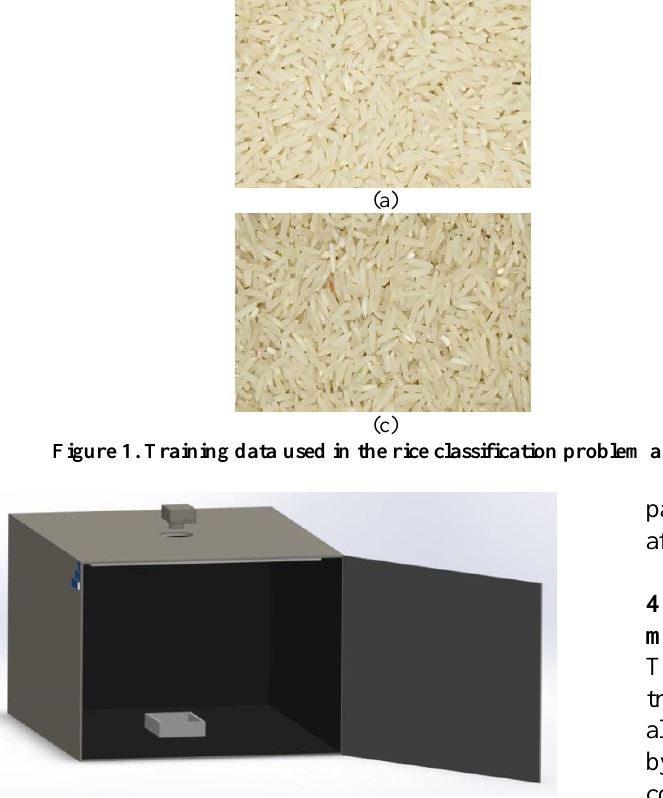
Figure 2. Box designed to record image of the rice